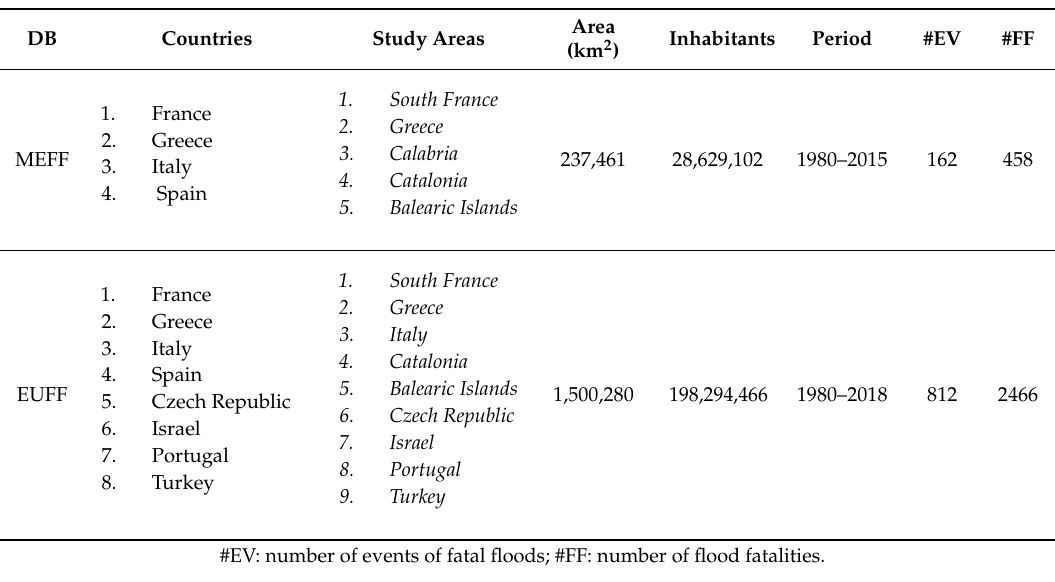
Table 1. Comparison of the MEFF (MEditerranean Flood Fatalities) and EUFF (EUropean Flood Fatalities) databases.